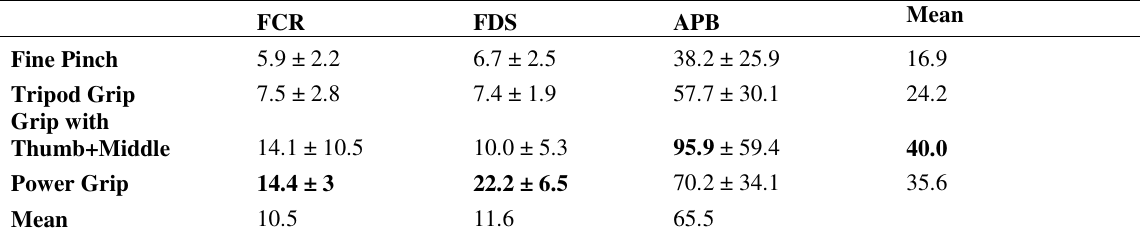
Mean values of EMG activity (mean ± SD) in in ( µ V) of different grips types for the case of 30% MVC for 5 subjects for FCR, FDS and APB muscles.